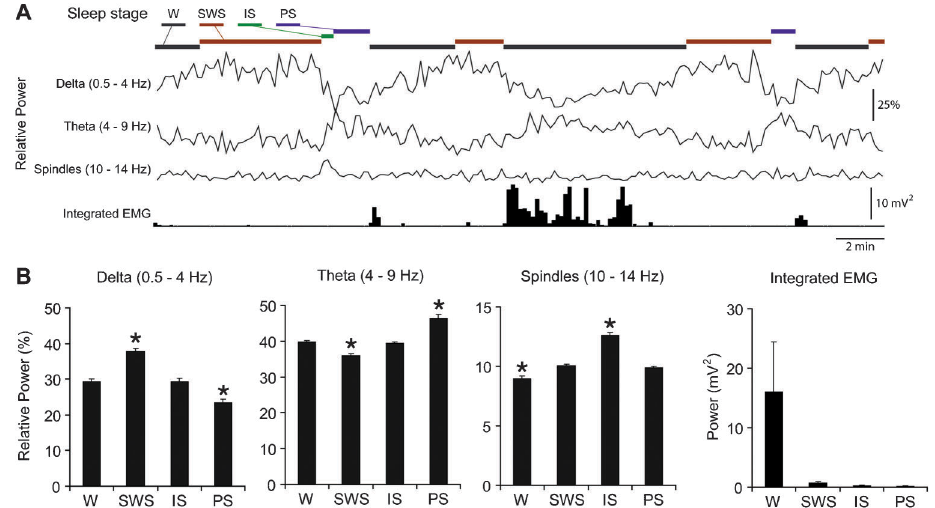
Figure 2. Time course of the sleep-wake cycles (SWC). A , Relative delta, theta and sigma power and absolute electromyogram (EMG) were computed using a 10-s sliding window fast Fourier transform and were correlated with scored hypnogram. This representative example shows the three most prevalent types of sleep transitions observed: slow-wave sleep (SWS) to intermediate sleep (IS) to paradoxical sleep (PS); SWS to PS and SWS alone. Note the increase in EMG power after an epoch of sleep. B , Grand averages of relative frequency bands across 8 mice (n=4/group) in each of the four SWC states recorded continuously during 48 h were calculated. As expected, delta oscillations were higher and lower during SWS and PS, respectively, while the opposite was observed during theta oscillations. Similarly, sleep spindles power was higher during IS and lower during awake (W). Data are reported as means±SE. *P , 0.05, compared to all other states (Bonferroni post hoc test).